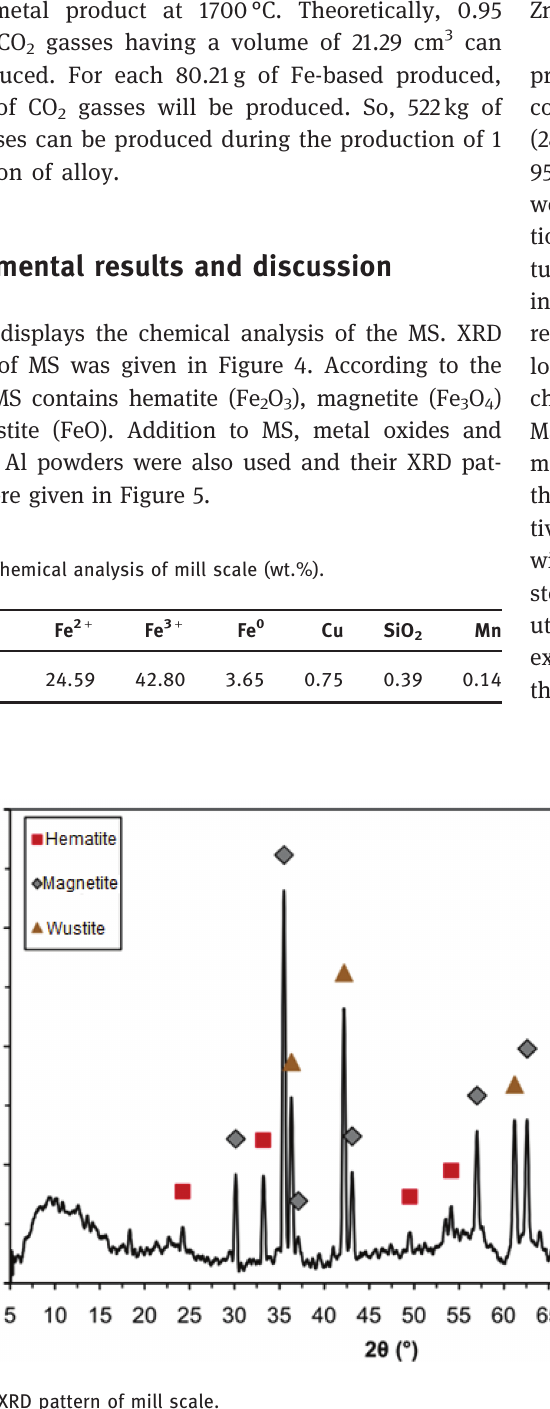
Figure 4: XRD pattern of mill